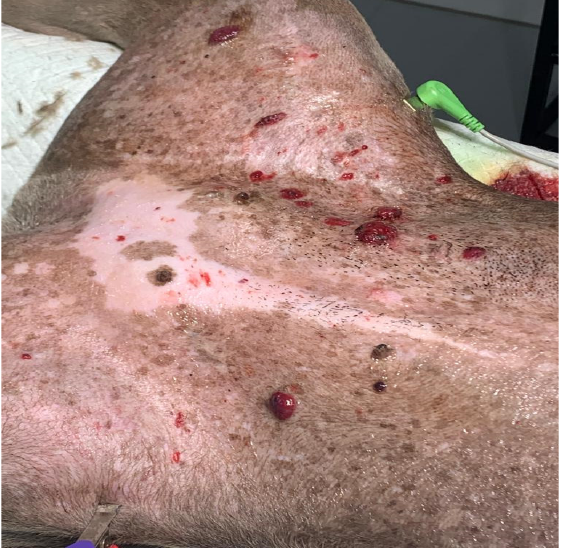
Figure 3. Multiple actinic lesions in a Pit Bull dog that had a history of chronic sun